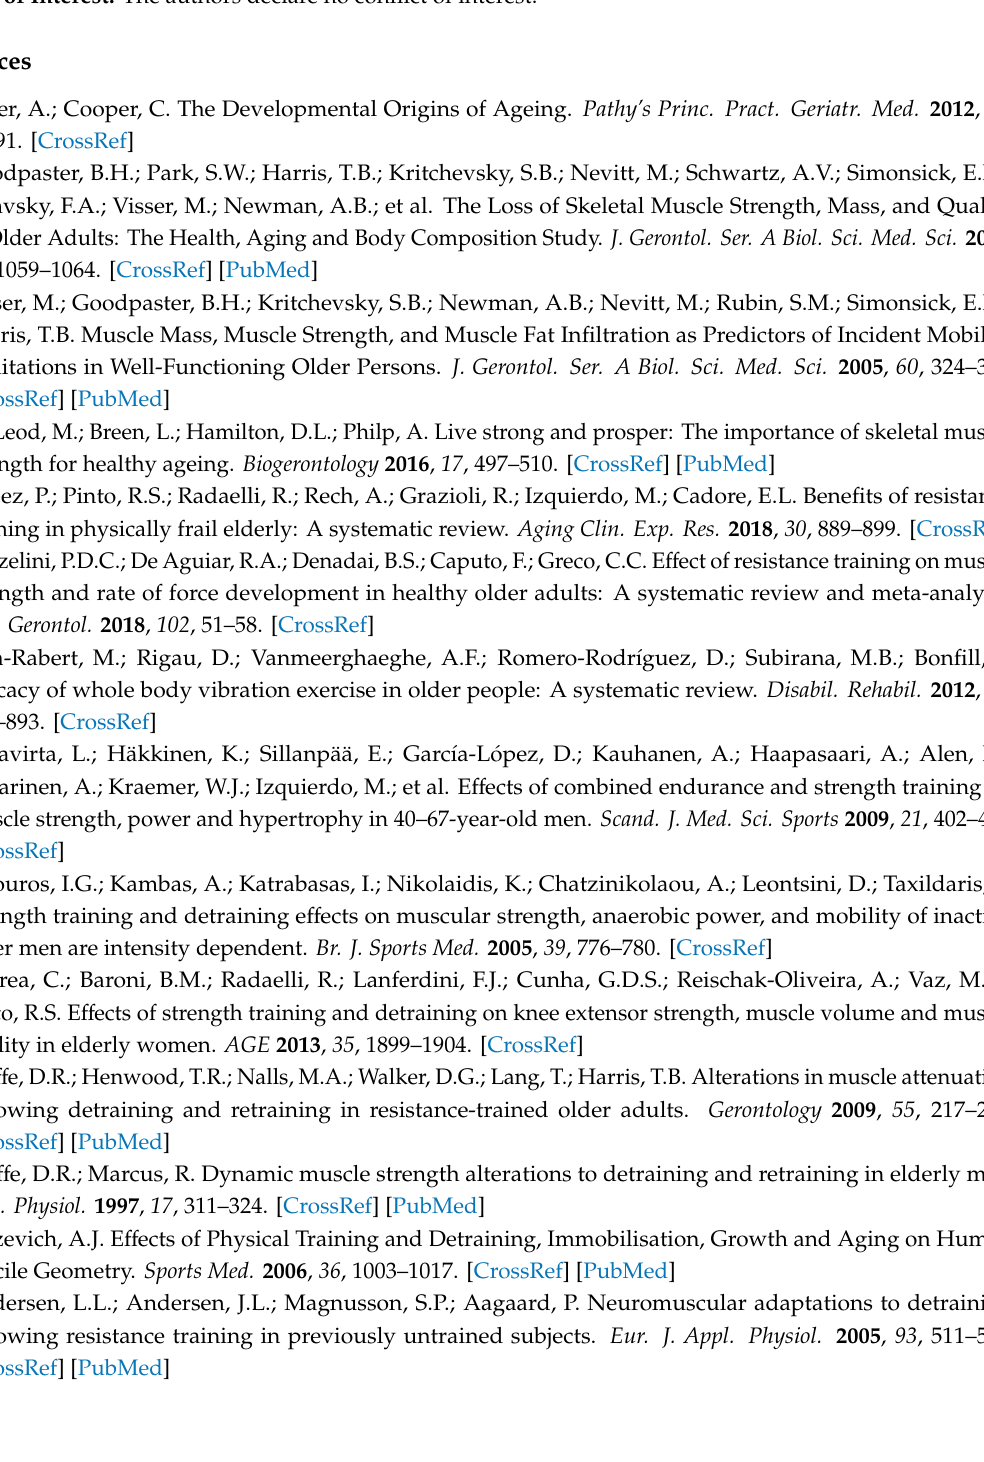
Table S1: The training programs, Table S2: 224 muscle-related SNPs, Table S3: Correlated SNPs and published references, Table S4: 170-SNP pool, Table S5: Common gene